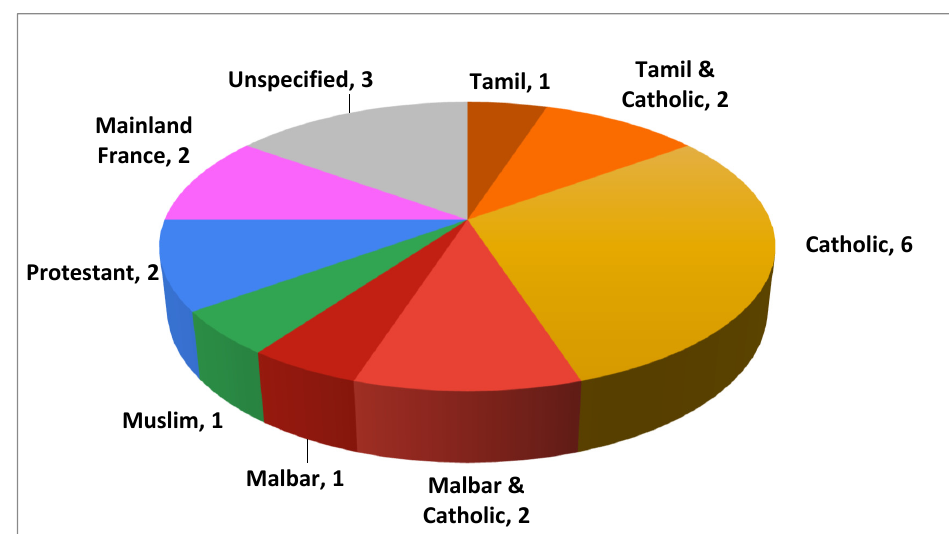
Figure 2. Self-Reported Ethnicity of Women Participants Born in Reunion.